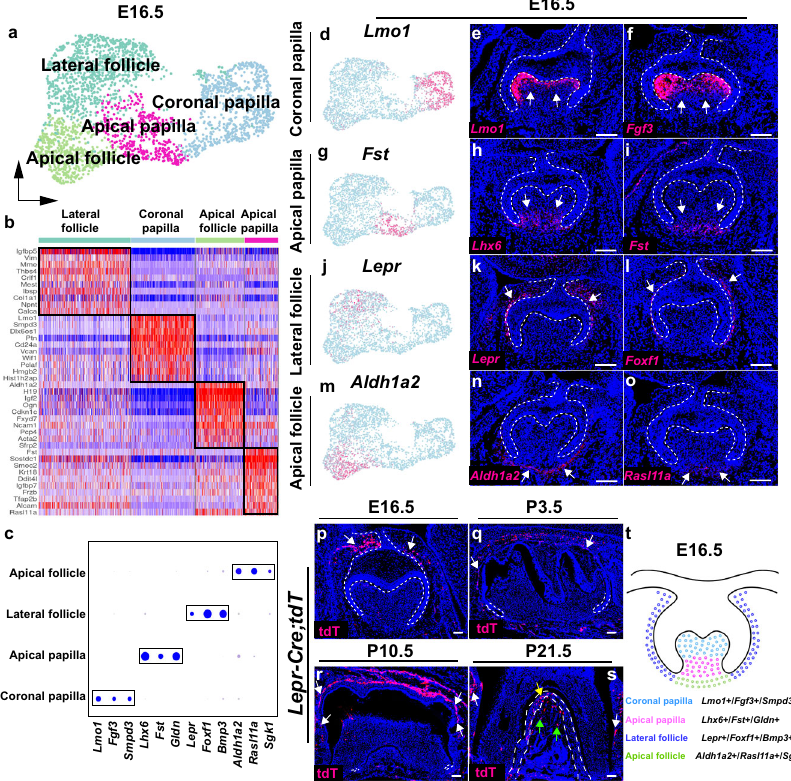
Fig. 3 | Dental cell populations evolve into four distinctive cellular domains at E16.5.a UMAPplotofcellclustersinthedentalmesenchymeofthemousemolarat E16.5. b , c HeatmapandDotplotofsignaturegenesinthedentalpapillaandfollicle of the mouse molar at E16.5. d – o Feature plot and RNAscope staining of dental papilla and dental follicle markers in the mouse molar at E16.5 ( n =3). p – s Lineage tracing experiment performed with Lepr-Cre;tdT mice ( n =3). t Schematic drawing